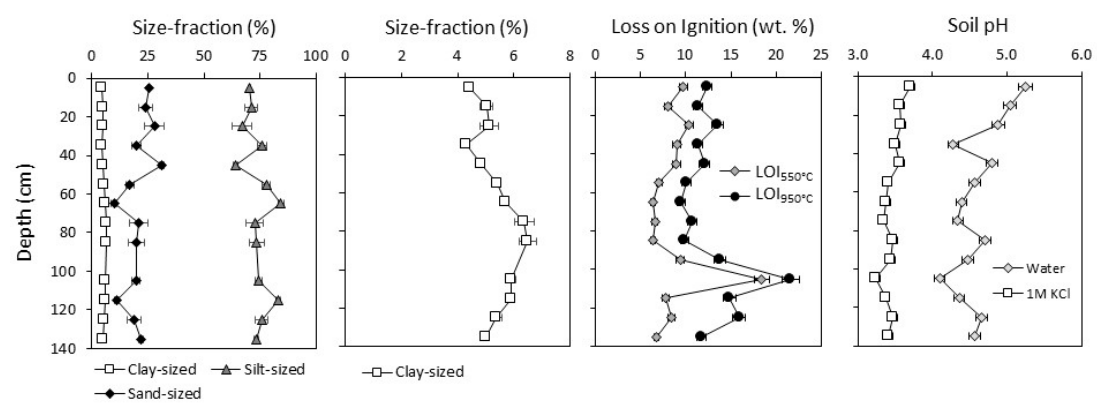
Figure 2. Soil properties measured on bulk soil collected in 10-cm depth increments. Error bars represent the maximum standard deviation of triplicate analyses on select soils.